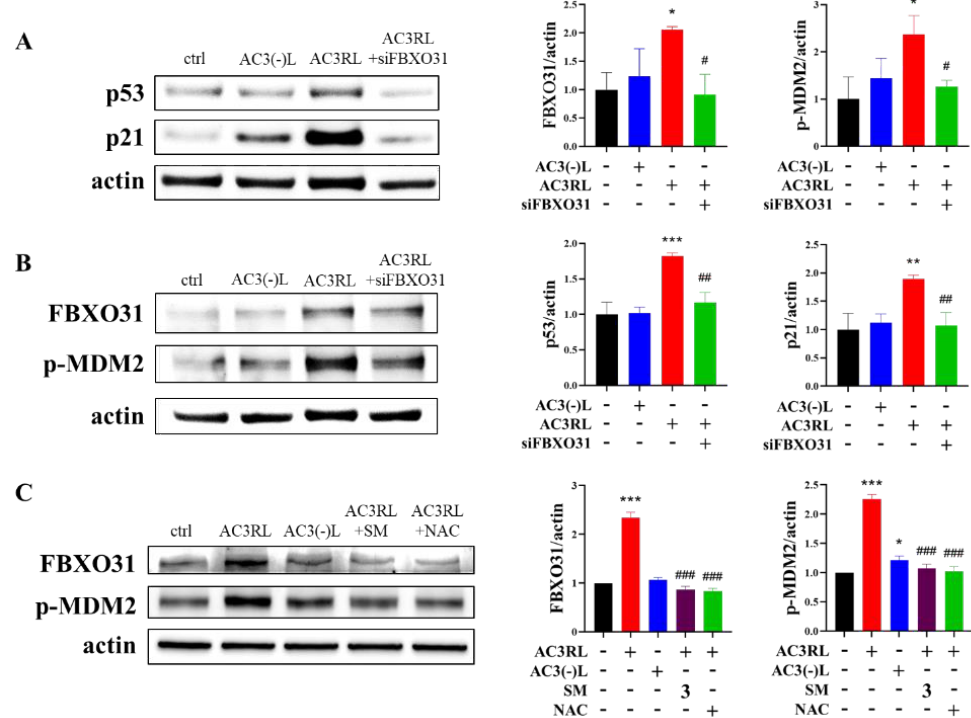
Figure 4. The signaling of AC3RL-induced senescence in HAECs. HAECs were incubated with PBS (control, ctrl), AC3(-)L (25 µ g/mL), AC3RL (25 µ g/mL), AC3RL + siFBXO31 (20 nM), AC3RL + NAC (5 mM), or AC3RL + SM (3 μ M) for 24 h ( A – C ). Then, the protein expressions of p53 and p21 ( A ) or FBXO31 and p-MDM2 ( B , C ) were determined using Western blotting. Actin was used as an internal control. For the quantitative analyses, n = 3 per group. * p < 0.05, ** p < 0.01, *** p < 0.001 vs. control; # p < 0.05, ## p < 0.01, ### p < 0.001 vs. AC3RL. 3.4. AC3RL-Induced Vascular Endothelial Senescence and the Inhibitory Effect of Sesamol To confirm the effects of AC3RL-induced senescence in vivo, we used a high-fat diet (HFD) to induce dyslipidemia in Syrian hamsters. The Syrian hamsters were fed a chow diet (control), an HFD, or an HFD supplemented with 50 or 100 mg/kg SM via oral gavage (HFD + SM) for 18 weeks ( n = 10 per group). First, we analyzed the apolipoprotein component of LDL in each treatment hamster. We found that the hamsters of the HFD group had a higher ApoC3 content in their LDL than that of the control group (Figure 5A). These data indicate that the hamster HFD group had higher levels of endogenous AC3RL than the control group. Moreover, we examined aortic endothelial senescence and the atherogenic properties of AC3RL. SA- β -gal staining and Oil Red O staining of the thoracic aorta or arch aorta of hamsters showed endothelial senescence and lipid accumulation in the HFD group (Figure 5B,C). Next, we examined DNA damage, FBXO31, and the MDM2 expression of AC3RL in vascular tissue. Immunofluorescence staining showed nuclear γ H2AX deposition and MDM2 protein downregulation on the luminal side of the thoracic aorta and the MDM2 mRNA down-expression and FBXO31 mRNA up-expression of thoracic aorta tissue in the HFD group. However, oral gavage of SM (50 mg/kg or 100 mg/kg) administered to the hamster HFD group remarkably reduced ApoC3 expression among the LDL (Figure 5A); arrested vascular endothelial senescence (Figure 5B), lipid accumulation (Figure 5C), and protein expression (Figure 5D); and